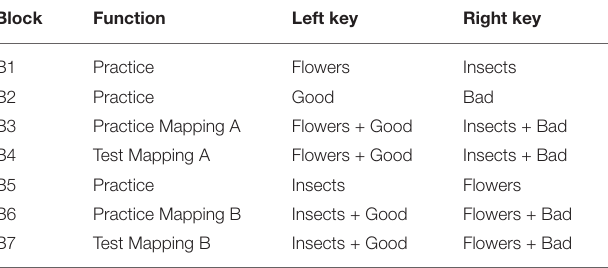
TABLE 1 | IAT blocks and conditions, adapted from Greenwald et al. (2003). TABLE 2 | Overview of the D-score